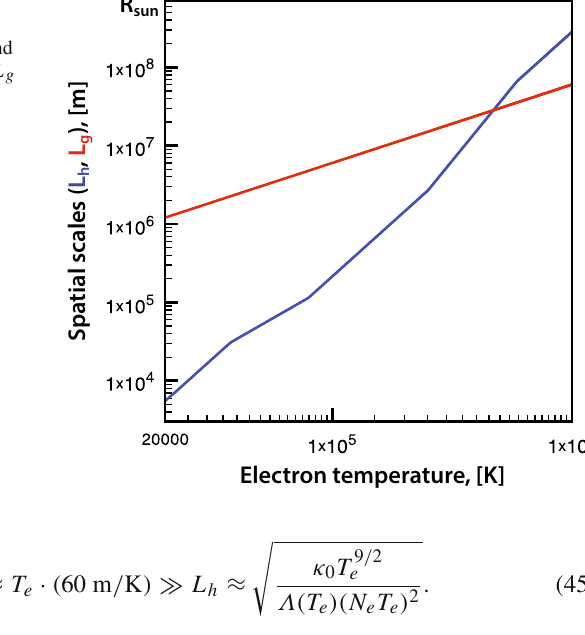
Fig. 21 Typical scales of the transition region: the heat conduction scale (blue), L h , and the gravitational height (red), L